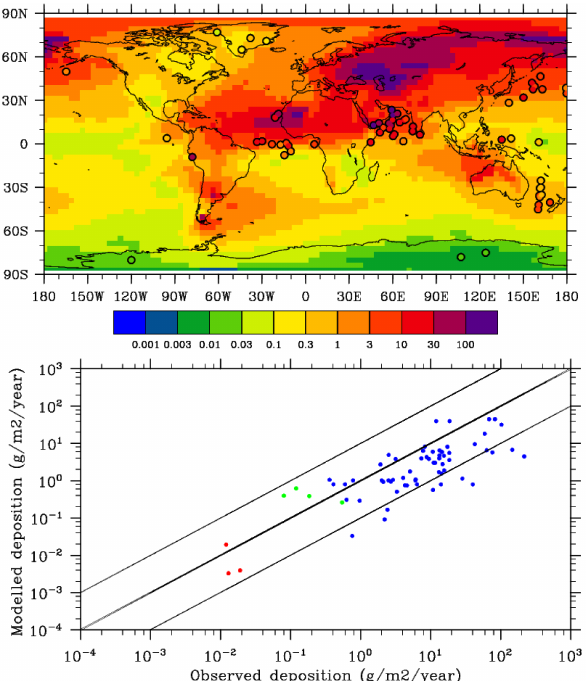
Figure 5. Top: simulated dust deposition flux (gm − 2 yr − 1 ) for the LGM time slice compared with dust deposition data compiled from ice cores, marine sediment traps and marine sediment cores (gm − 2 yr − 1 ; circles). Bottom: scatter plot comparing modelled and observed deposition. Red indicates Antarctica, green indicates Greenland and blue indicates other locations.